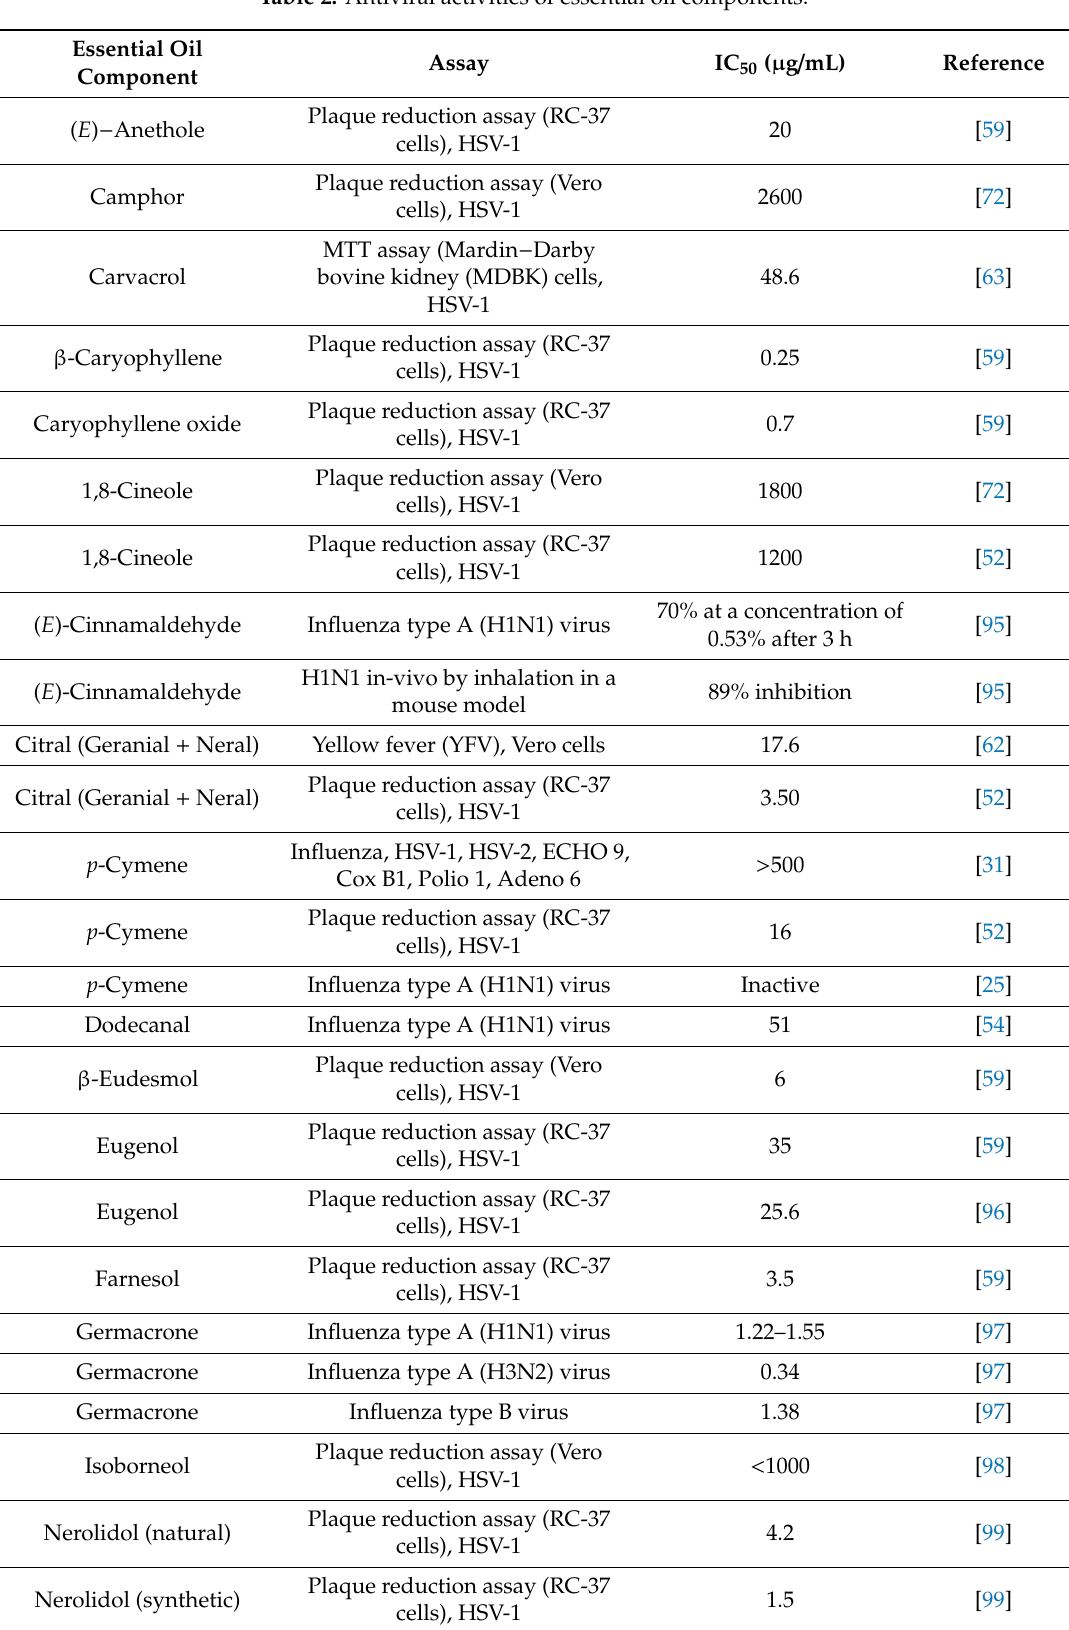
Table 2. Antiviral activities of essential oil